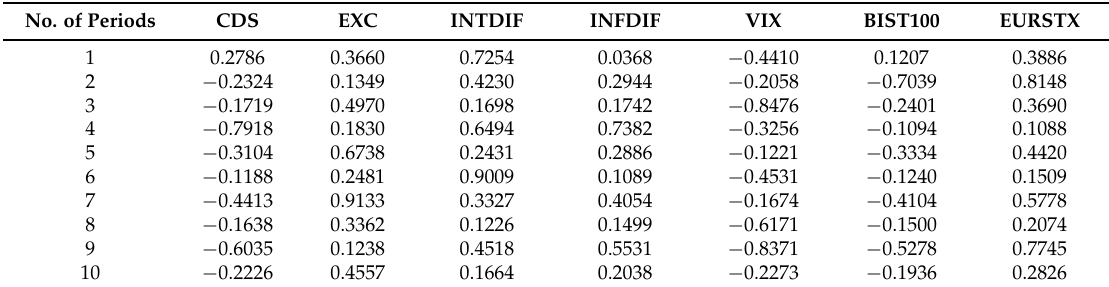
Table 7. Response of EXC to 1% positive shock in other variables in regime 1.